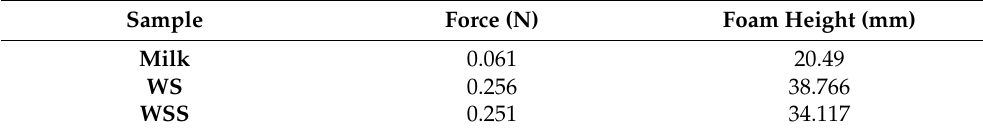
Table 5. Comparison of foaming properties of WAPC (WS) and WAPC SFE (WSS) compared to semi-skimmed milk, n = 1.